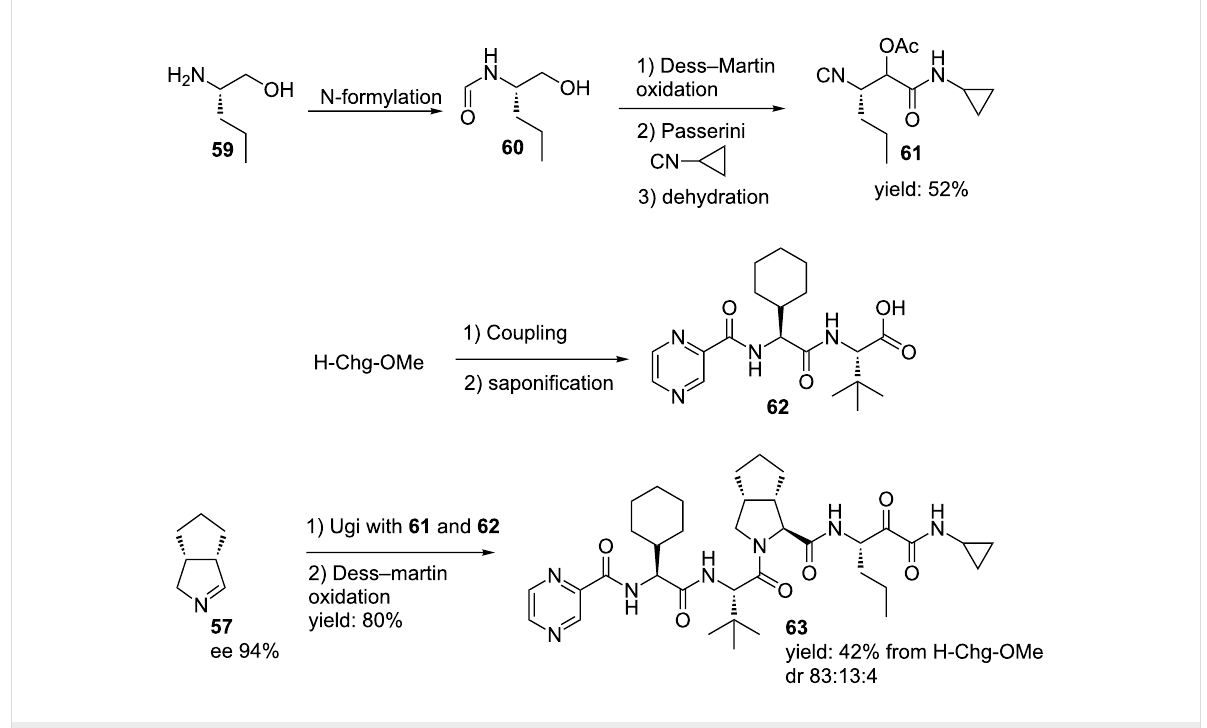
Scheme 19: MAO-N/MCR-approach towards the hepatitis C drug telaprevir.